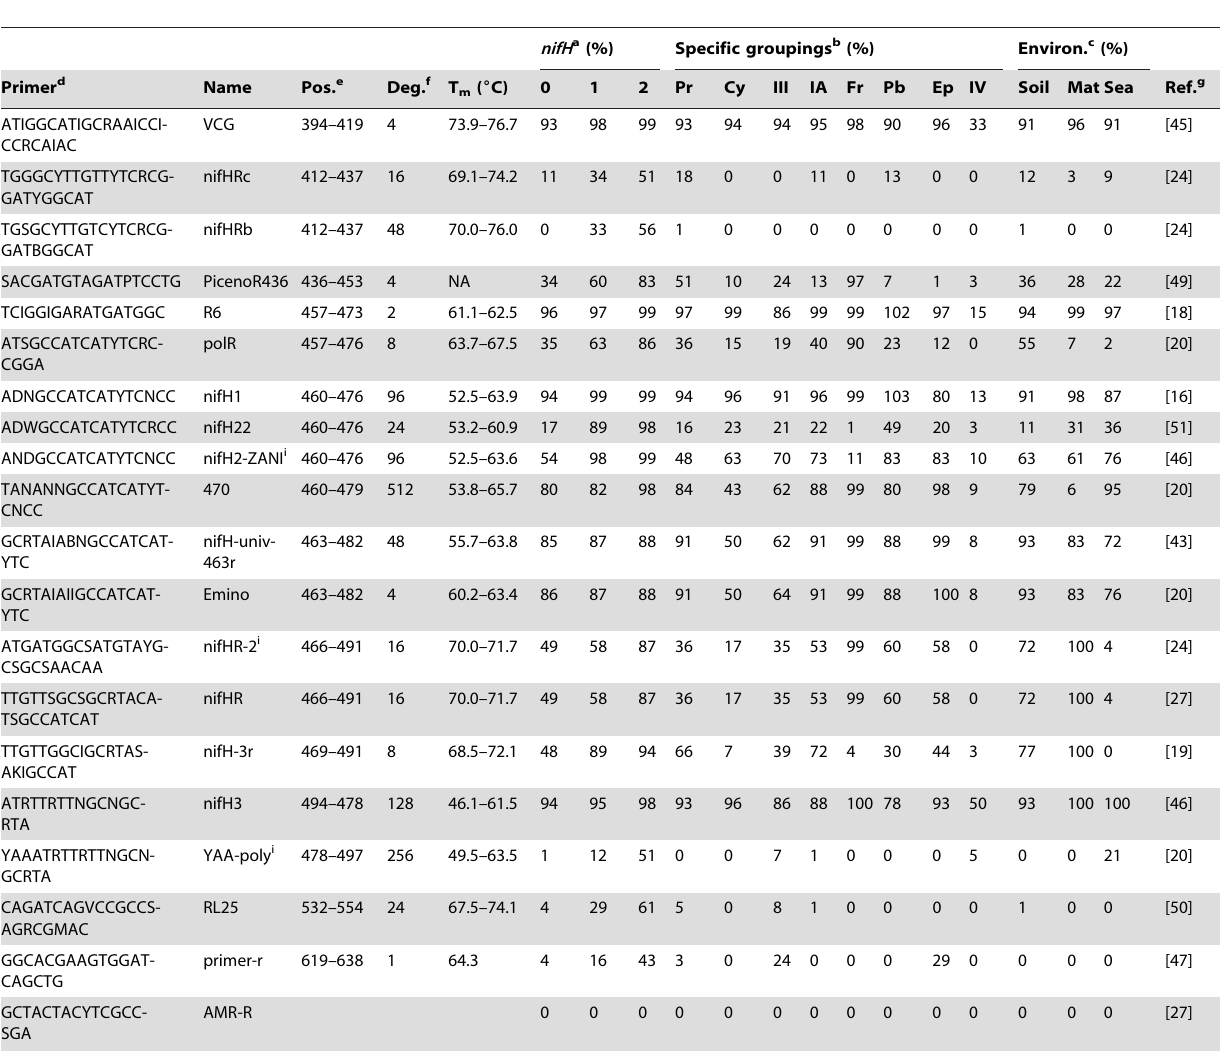
Table 2. Properties of universal primers and their coverage for phylogenetic and environmental groupings in the nifH database; continued from Table